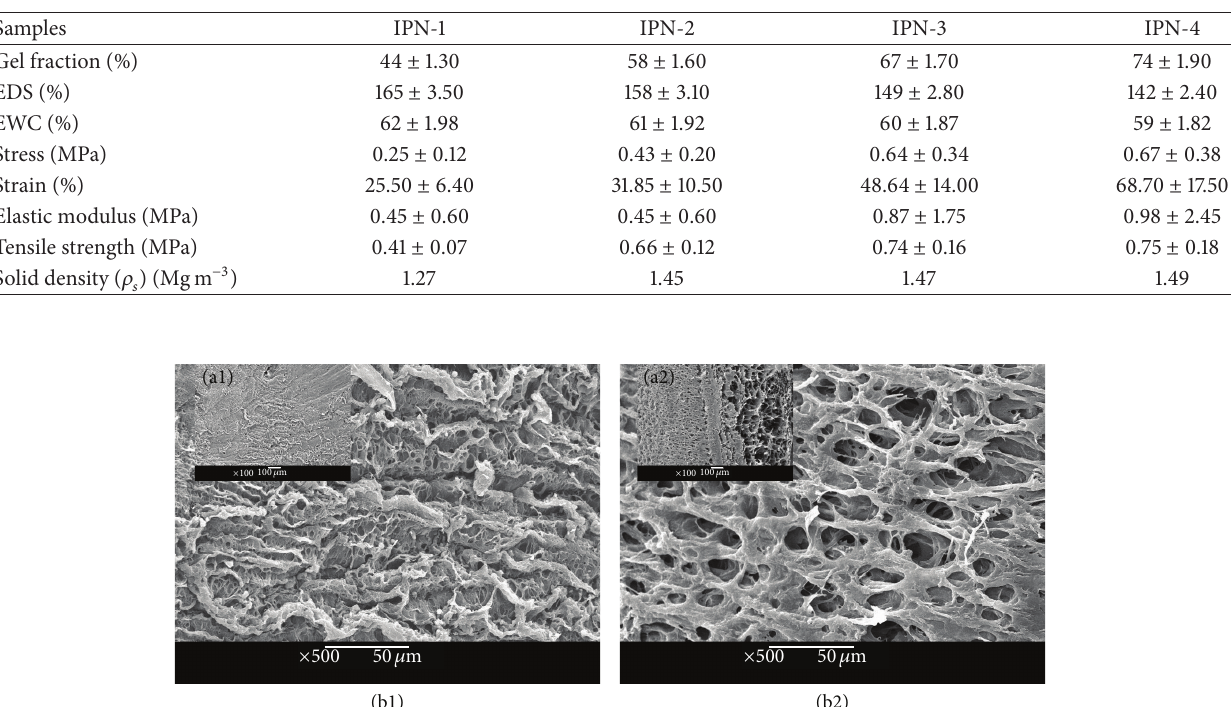
Table 3: The properties of IPN PVA/GE hydrogels after three freezing-thawing cycles.